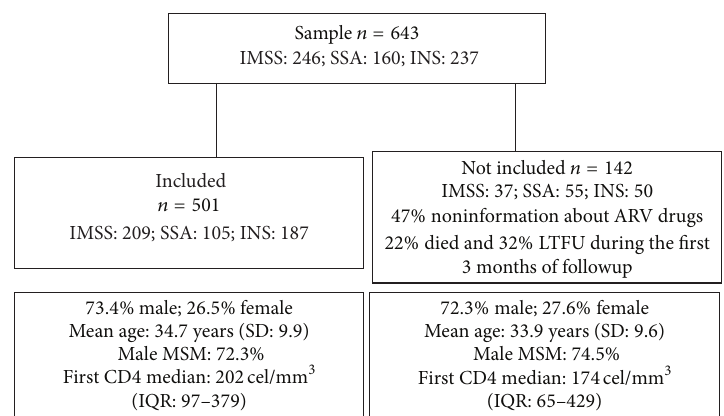
Figure 1: Comparison between patients who were included and patients who were not